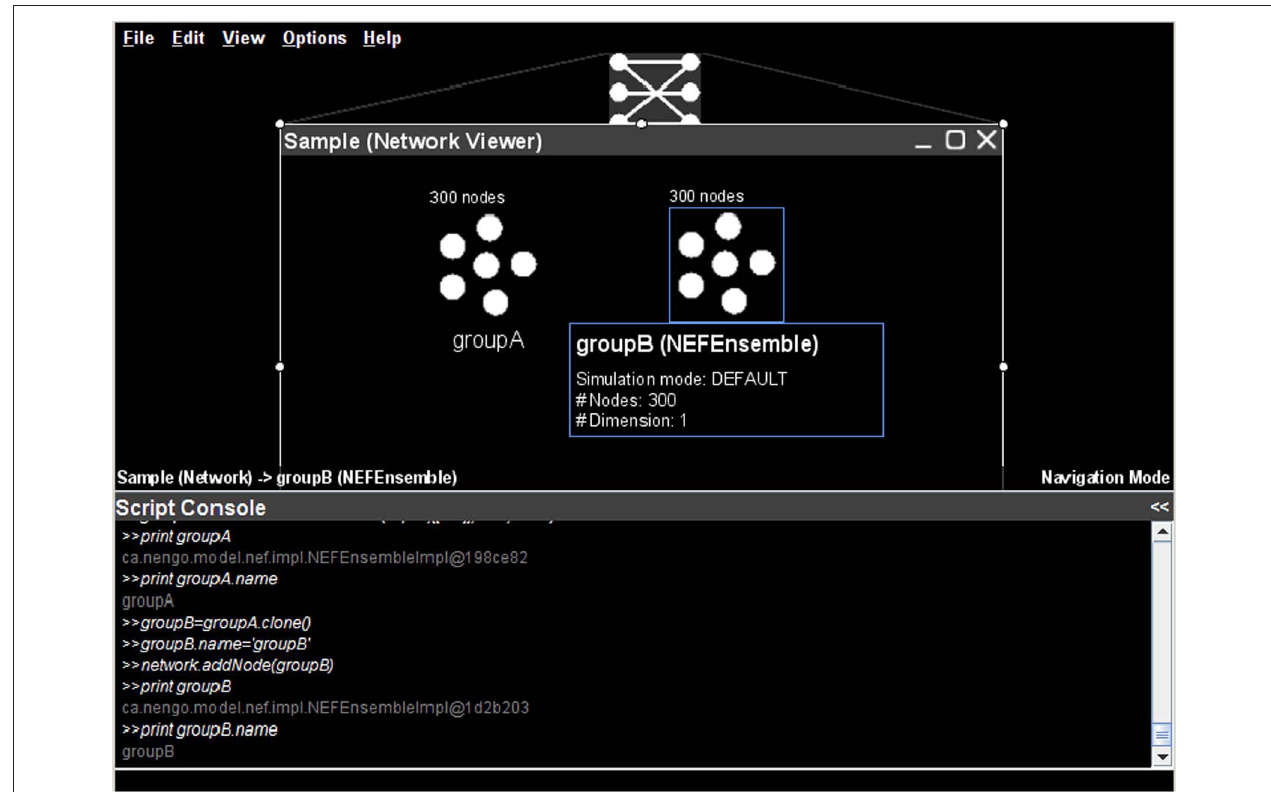
FIGURE 4 | Basic usage of the Python scripting interface to interact programmatically with a neural